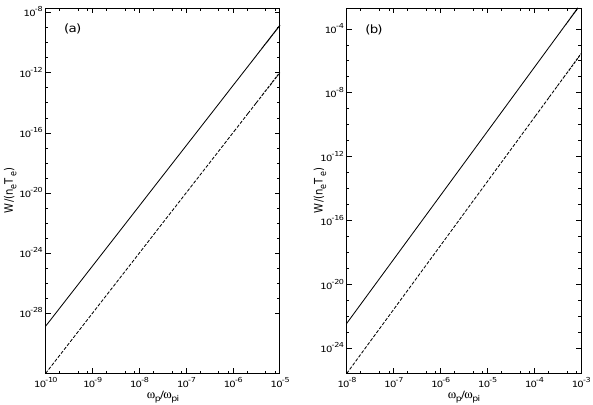
Figure 3. The dependence of threshold amplitude of pump wave on the frequency of pump wave for the maximum value of growth rate γ NL (cid:39) 0 . 0009 for forward decay as well as for γ NL (cid:39) 0 . 056 for reverse decay. Here we consider the parameters of solar wind plasma (a) as well as the plasma parameters of F region of Earth’s ionosphere (b) . The solid line denotes the forward decay, and the dashed line denotes the reverse